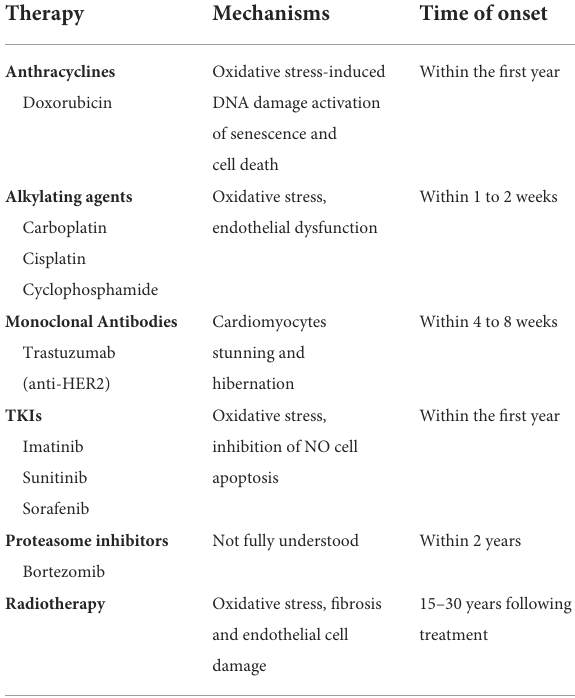
TABLE 2 Main cancer therapies that can induce cardiomyopathies in cancer